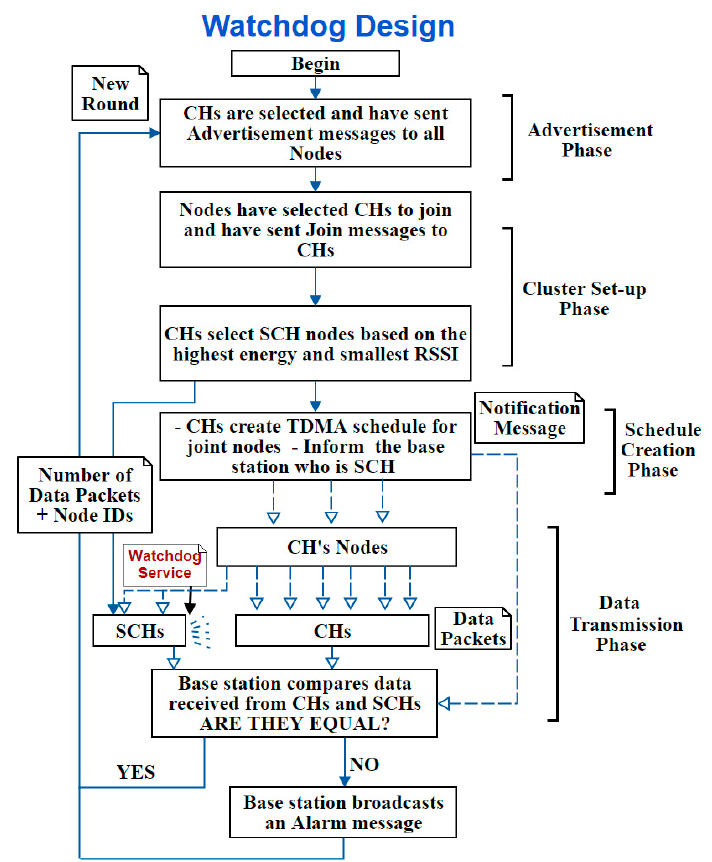
Figure 8. Watchdog design process.